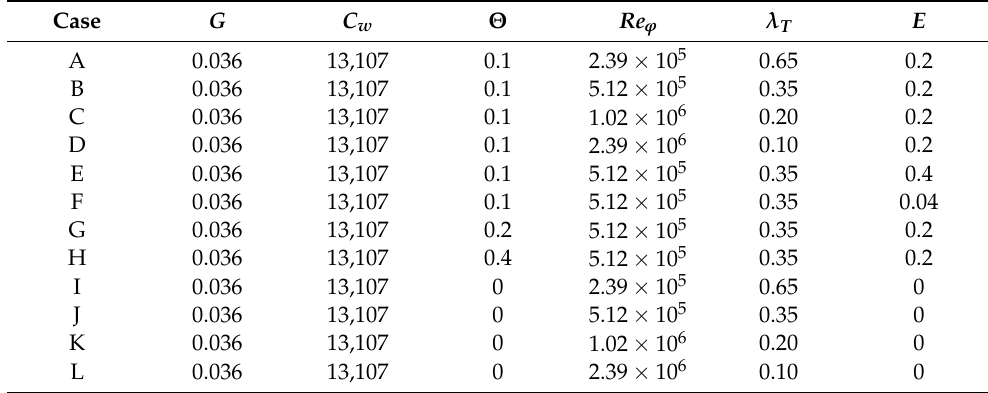
Table 1. The range of parameters.